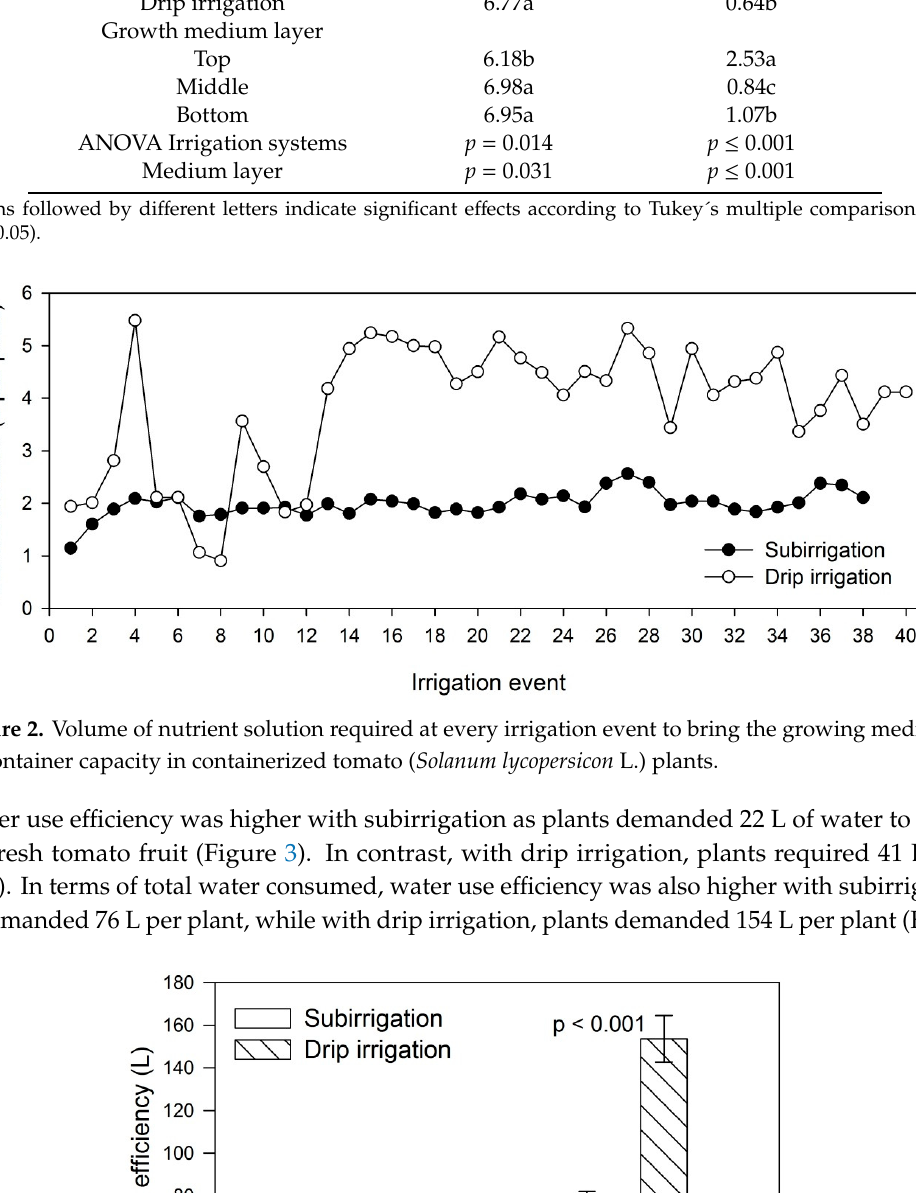
Table 2. Growing medium pH and electrical conductivity (EC) at experiment termination as a ff ected by two irrigation systems and the root ball substrate layer of tomato ( Solanum lycopersicum L.) plants.